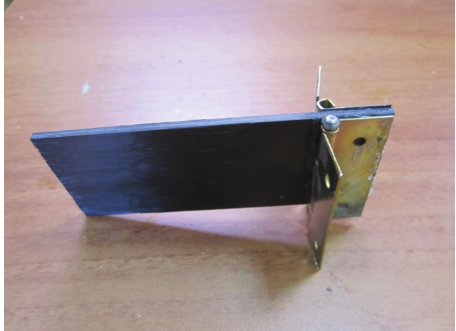
Figure 7 Specimen for DCB test.